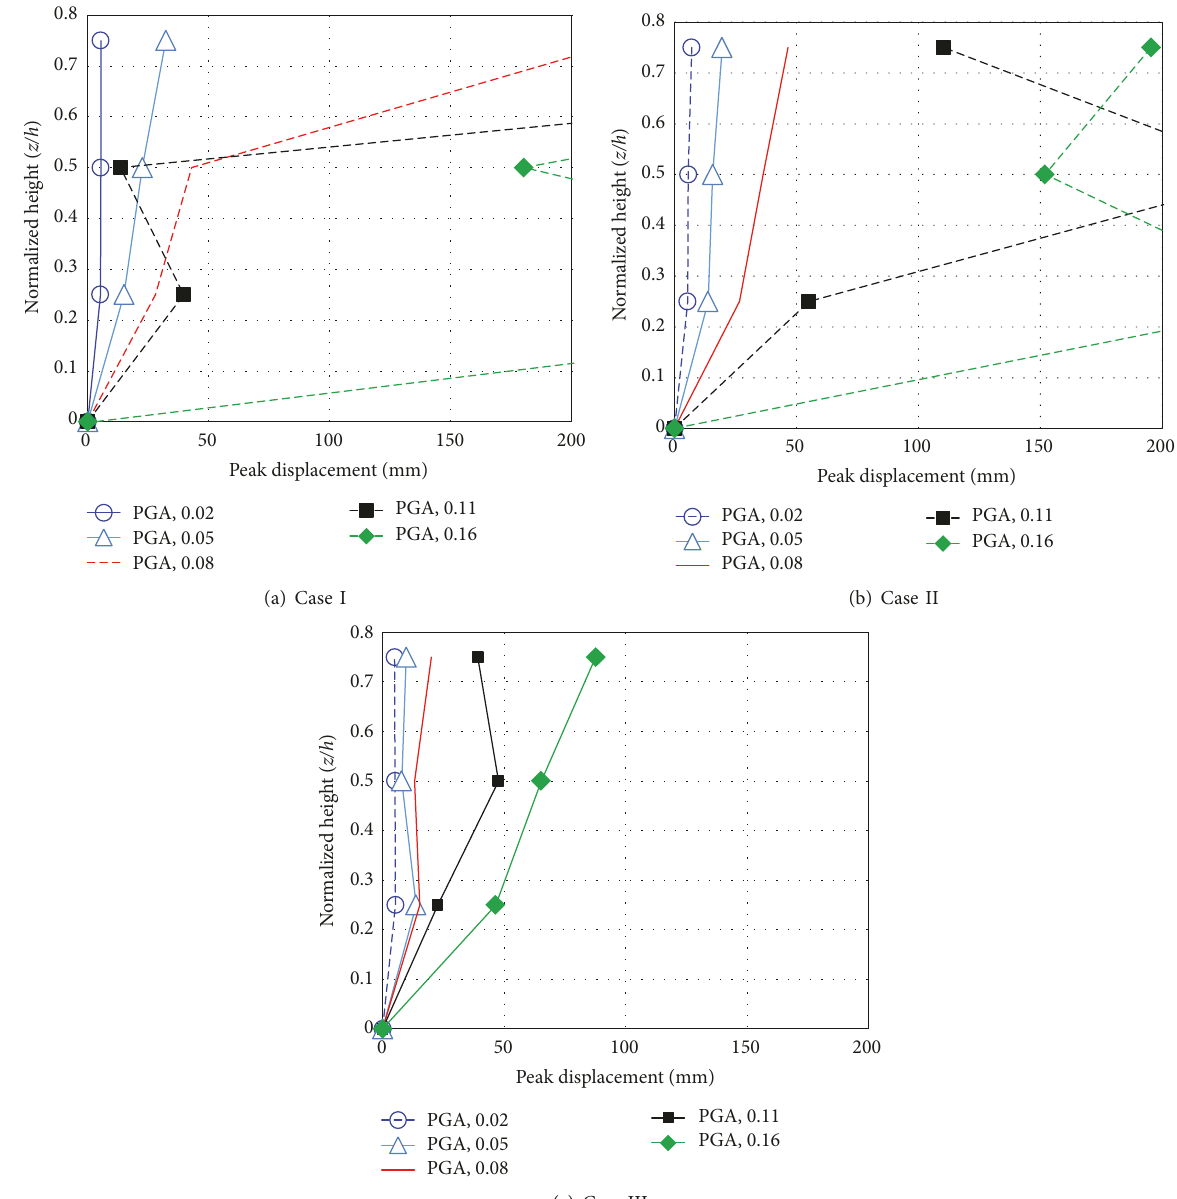
Figure 11: Displacement response of the walls under El-Centro ground motion with different intensities ( 𝐻/𝐿 = 0.6 ).